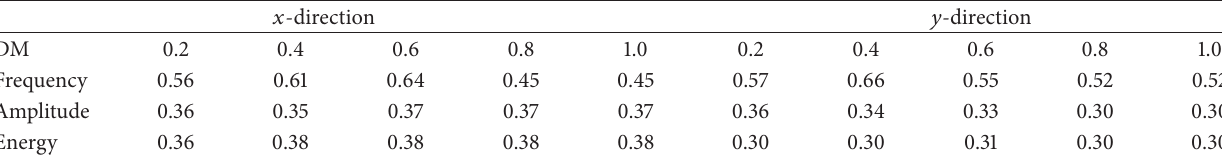
Table 6: Dispersion of intensity level for different damage